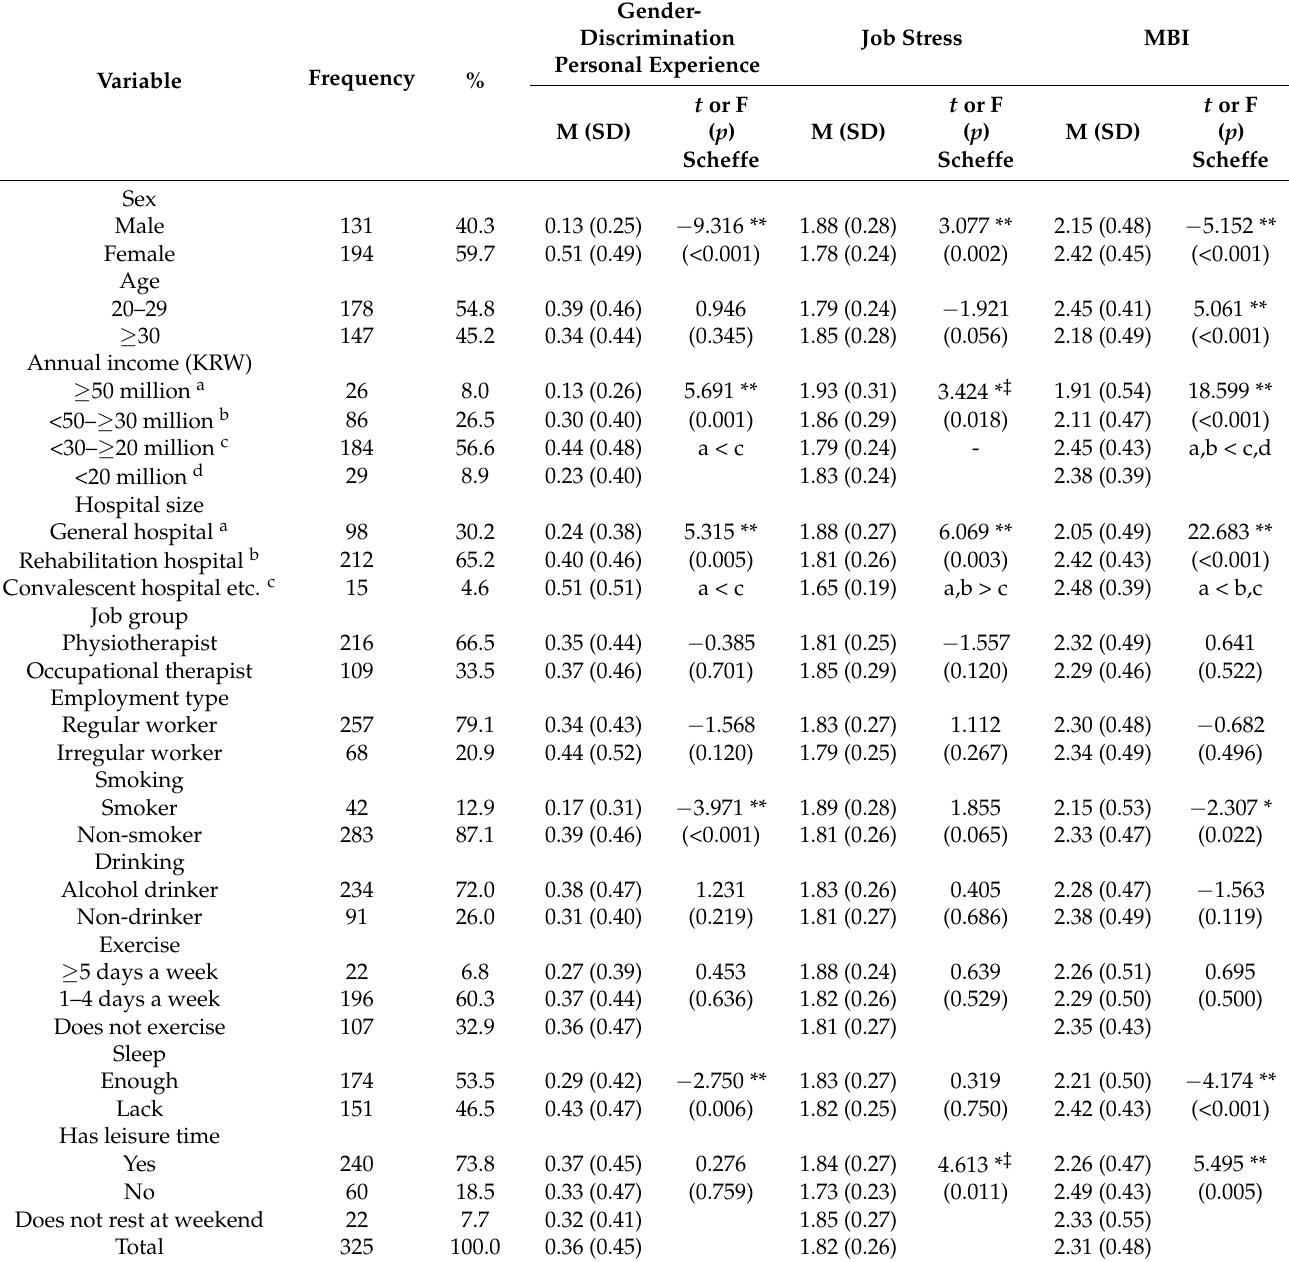
Table 1. General characteristics of rehabilitation professionals in gender-discrimination personal experience, job stress and burnout scale